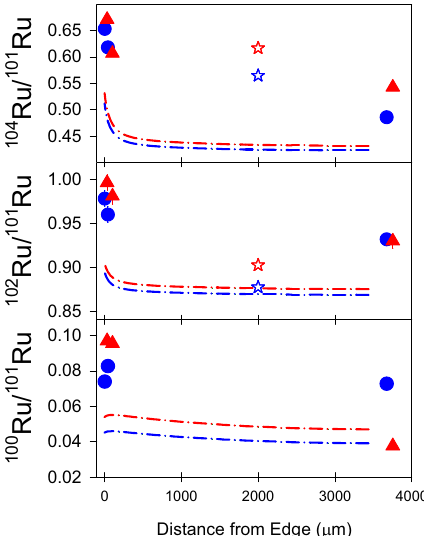
Figure 5. Ru isotope ratios as a function of radial position within a fuel pellet. See Fig. 4 caption and legend for details.